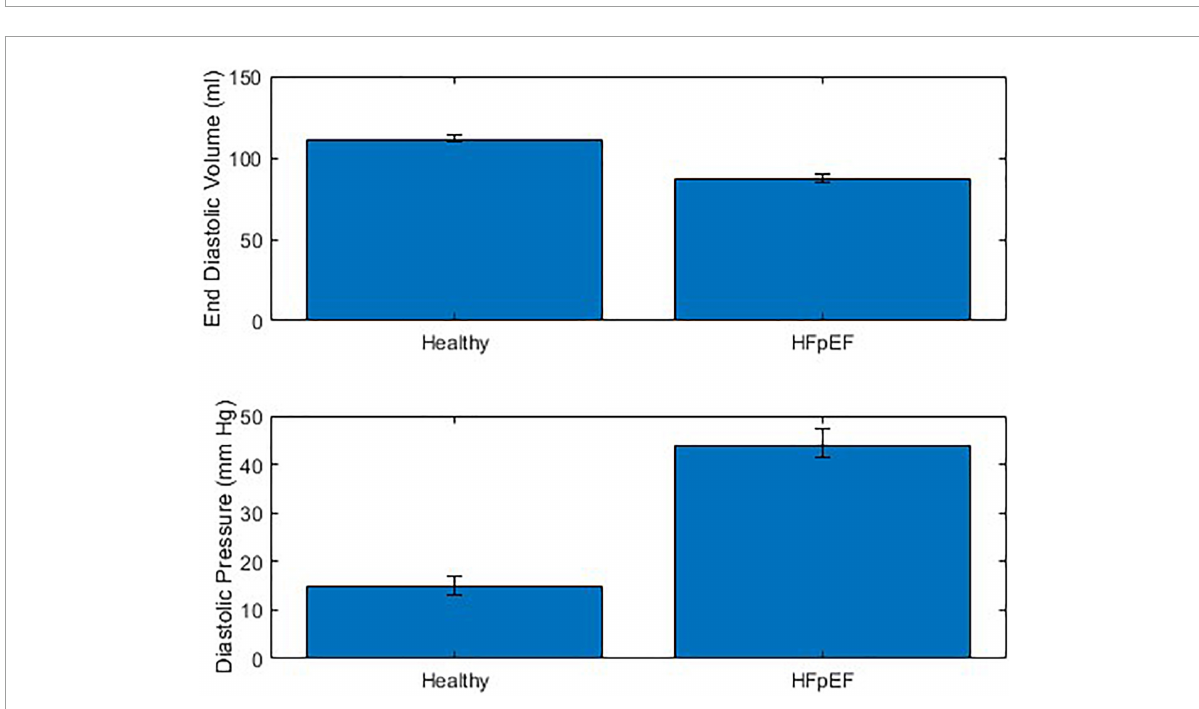
FIGURE7 Combined performance of MCL Mk I and Mk II at simulating healthy cardiac function and HFpEF across 10 cardiac cycles ( N = 30).